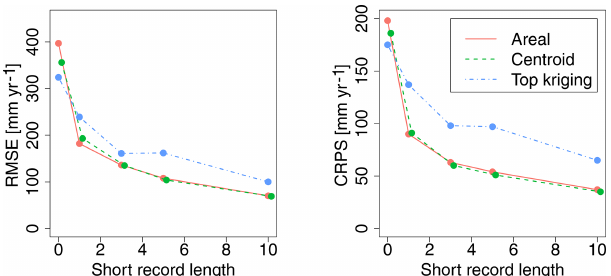
Figure 13. RMSE and CRPS as a function of record length (0, 1, 3, 5 and 10) for predictions of mean annual runoff for 1981–2010 for 83 fully gauged catchments in southern